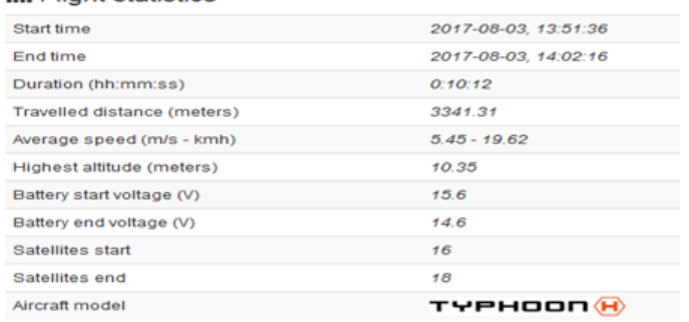
Figure 12. Sensor